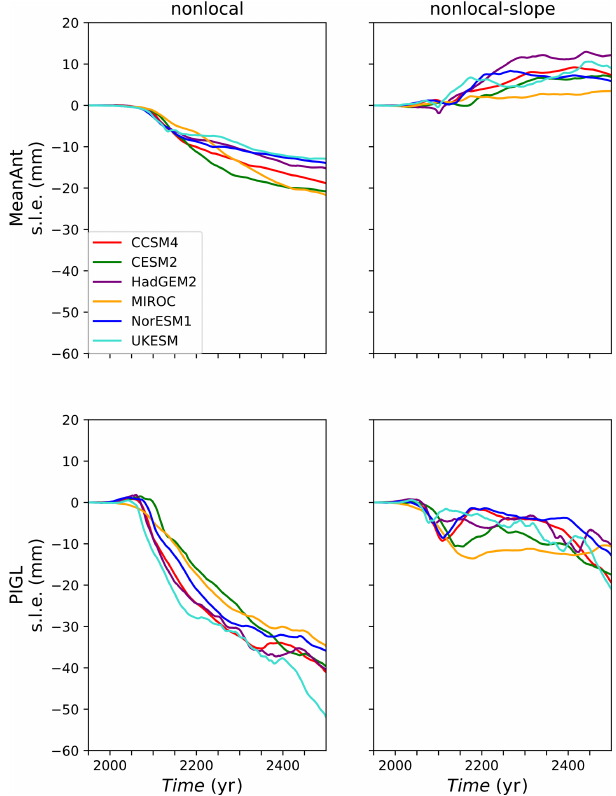
Figure 15. Difference in SLR contribution (mms.l.e.) during 550- year projection experiments on an 8km grid, comparing the Blatter– Pattyn (BP) and DIVA velocity solvers. Positive values indicate a greater SLR contribution in runs using the BP solver. The four pan- els correspond to the nonlocal and nonlocal-slope melt parameteri- zations with the MeanAnt and PIGL calibrations.